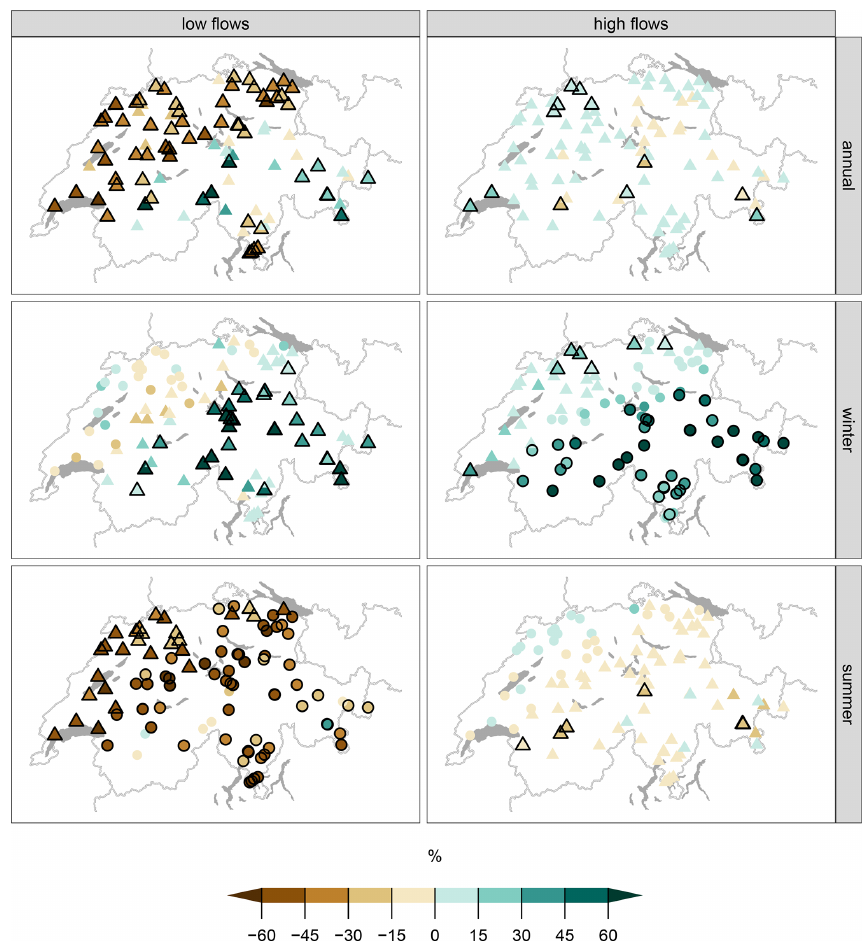
Figure 3. Relative changes of magnitude by the end of the century for moderate low flows (left panels) and moderate high flows (right panels) for the year (upper panels), the winter half-year (middle panels), and the summer half-year (lower panels). Triangles indicate catchments with annual moderate low and high flows occurring in the time window in the reference period. Circles indicate seasonal low and high flows outside the typical low- and high-flow season. Black contours indicate changes with at least 90% of the models agreeing on the direction of